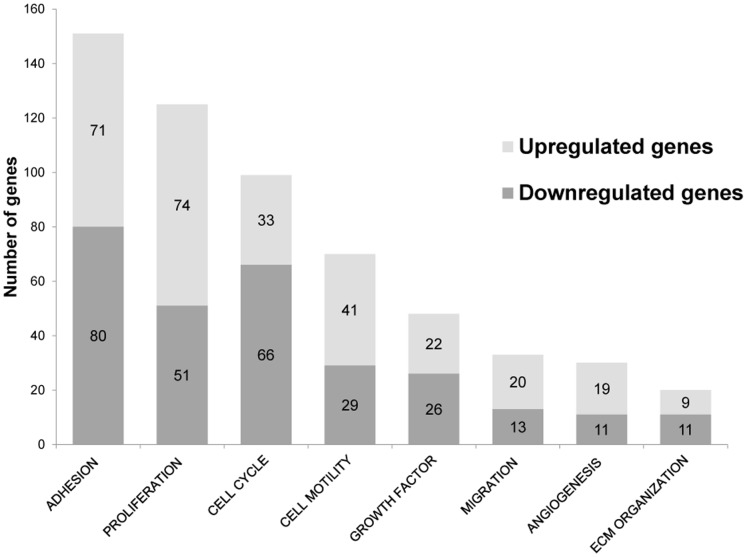
Differentially expressed genes following syndecan-1 overexpression grouped by functional categories according to Gene Ontology.Each differentially expressed gene (FC≥1.5 or FC ≤−1.5, q≤0.05 using OCplus test from R package) was assigned to functional categories using Gene Ontology database. Genes from each category were counted and plotted on the graph. Vertical axis represents the number of differentially expressed genes and each column represents a GO category.